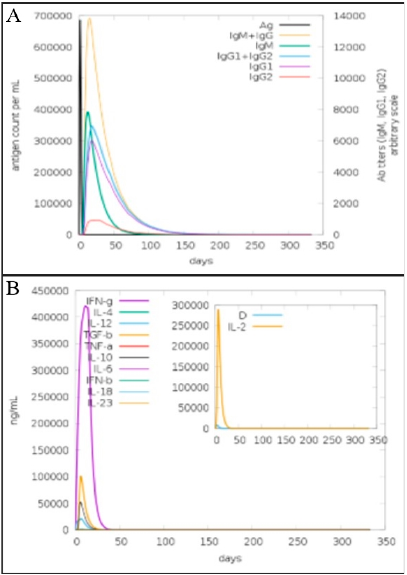
Figure 10. ( A ). Immunoglobulin titer (different color peak) in response to multi-epitopes vaccine injection (black color peak). ( B ). Elicitation of interleukins level after injection of multi-epitopes vaccine construct as represented by C- immune simulation analysis.